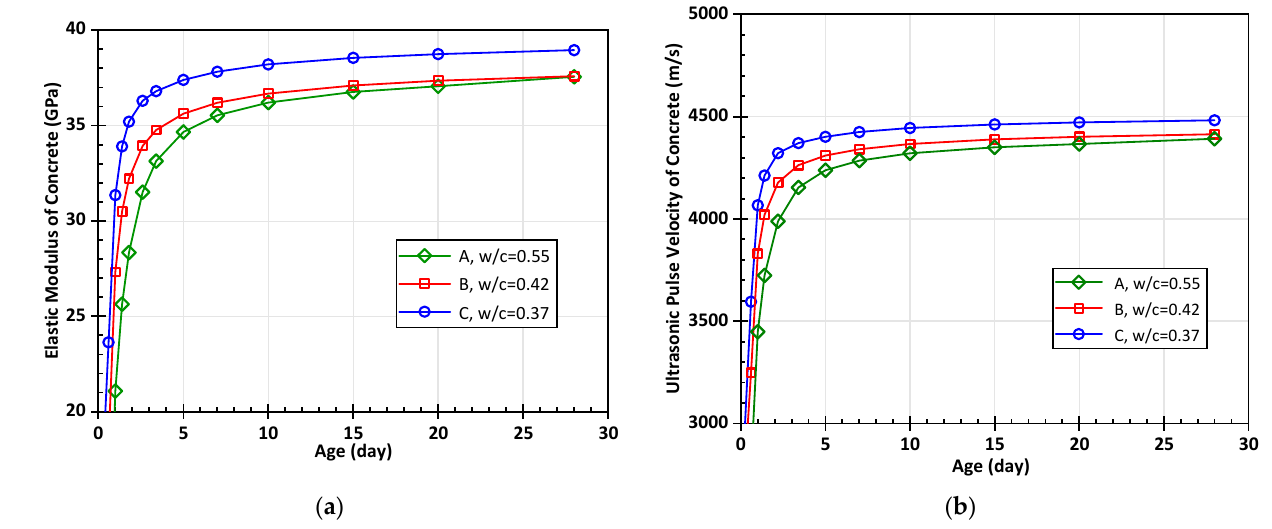
Figure 13. The predicted curves at different ages based on the multiscale ultrasonic pulse velocity prediction model: ( a ) elastic modulus and ( b ) ultrasonic pulse velocity.